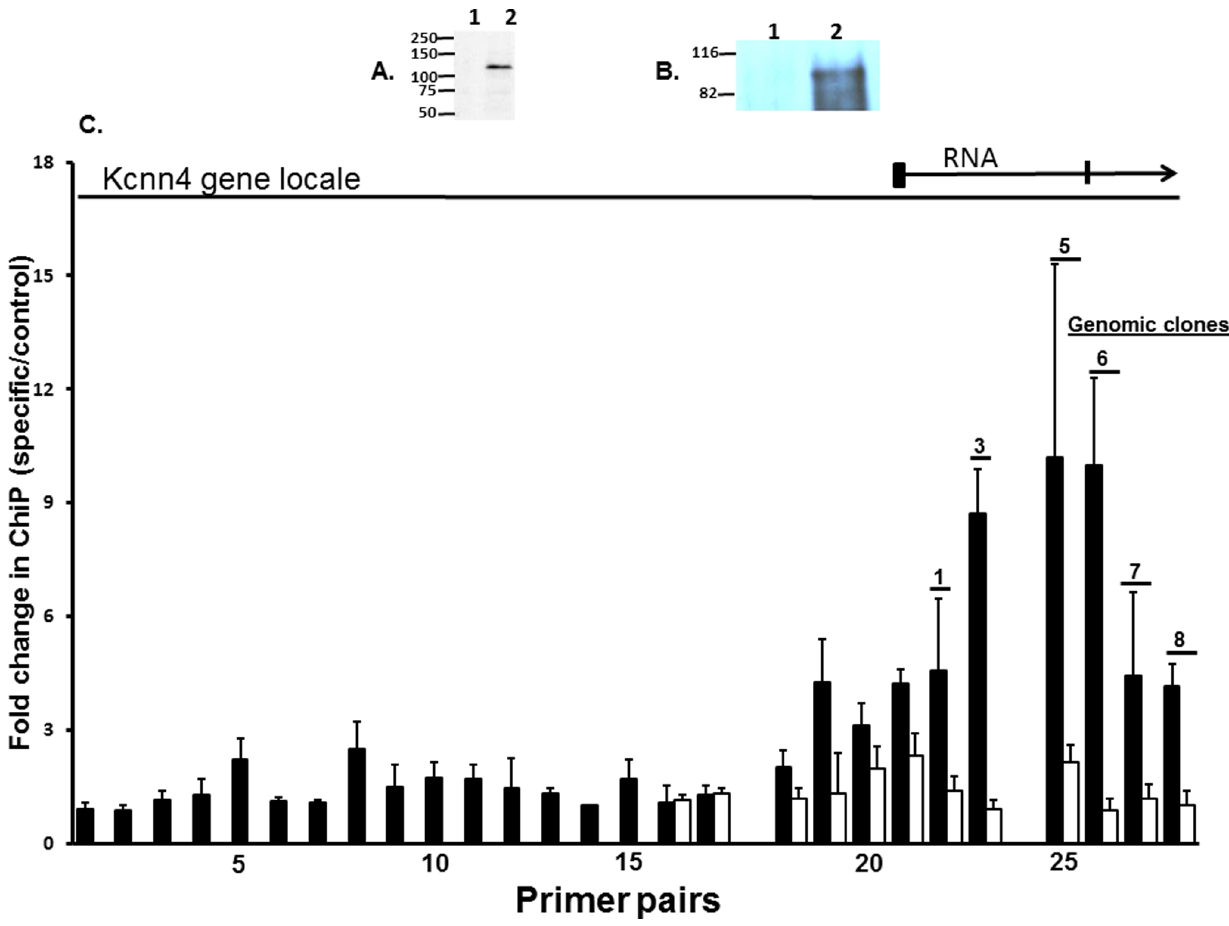
Figure 1. Characterization of anti-mineralocorticoid receptor antibody (SC-11412) and its use in chromatin immunoprecipitation (ChIP) assay. [ A ] Characterization of SC-11412 antibody : The CHOK1 cells were transfected with vector ( lane-1 ) or the vector containing a mineralocorticoid receptor (MR) ( lane-2 ), labeled with 35 S-methionine, immunoprecipitated with SC-11412 antibody to MR, resolved on SDS-PAGE, and the gel used to expose X-ray film. [ B ] Immunoprecipitation of MR-like proteins from rat colonic epithelial cells : Protein extracts of the colonic epithelial cells from an aldosterone rat was immunoprecipitated with the control ( lane-1 ) or the SC-11412 ( lane-2 ) antibody. The immnoprecipitated proteins were resolved on SDS-PAGE and transferred to the nitrocellulose membrane and probed with the SC-11412 antibody. [ C ] ChIP assay of MR : Numbers on the X-axis represent primer pairs directed to 1 kb blocks starting at approximately 20 kb upstream (number-1) of the Kcnn4 presumed transcript start site (TSS) and extending to 10 kb downstream (number-29) of the presumed TSS (located in block 21). The Y-axis represents fold enrichment in the RT-PCR comparing the specific to the control antibody. Data presented represents mean 6 SE of 4 independent experiments using distal colon epithelial cells from aldosterone ( closed bars ) and normal rats ( open bars ). The RNA transcript is indicated by an arrow. The presumed promoter region is immediately to the left of the arrow. Exons 1 and 2 are indicated by blocks. Genomic regions cloned in pGL4.23 are indicated by bars and are